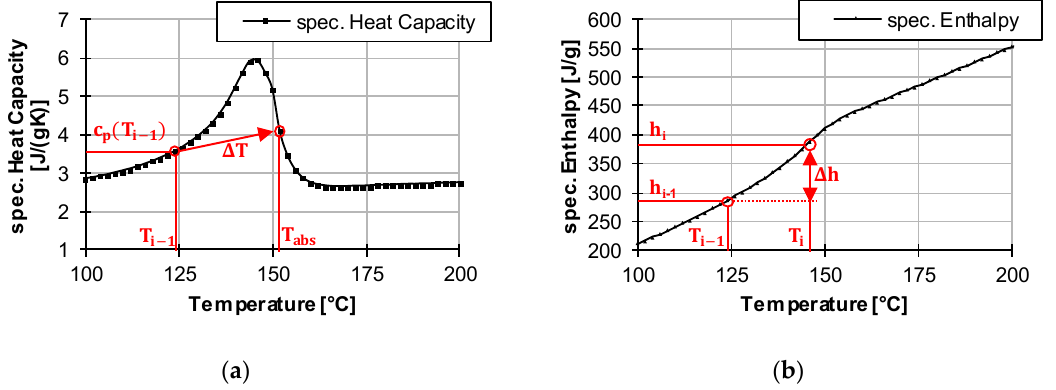
Figure 6. Comparison of the temperature difference when considering the specific heat capacity ( a ) or the specific enthalpy ( b ).